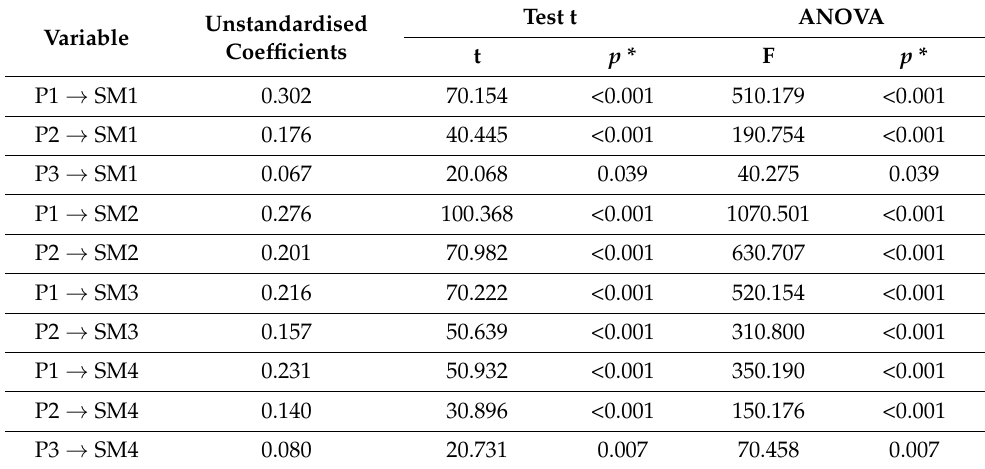
Table 11. Participation vs. Smart Mobility—linear regression results.